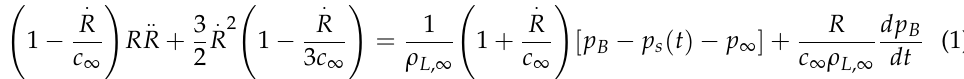
where R is bubble radius, dot denotes the time derivative (d/dt), c ∞ is the sound speed in the liquid far from a bubble, ρ L , ∞ is the liquid density far from a bubble, p B is the liquid pressure on the external side of the bubble wall, p s ( t ) is a nonconstant ambient pressure component such as a sound field ( p s ( t ) = − A sin ω t , where A is the acoustic amplitude and ω is angular frequency of ultrasound), and p ∞ is the undisturbed pressure. The method of numerical simulations is simply as follows [5].